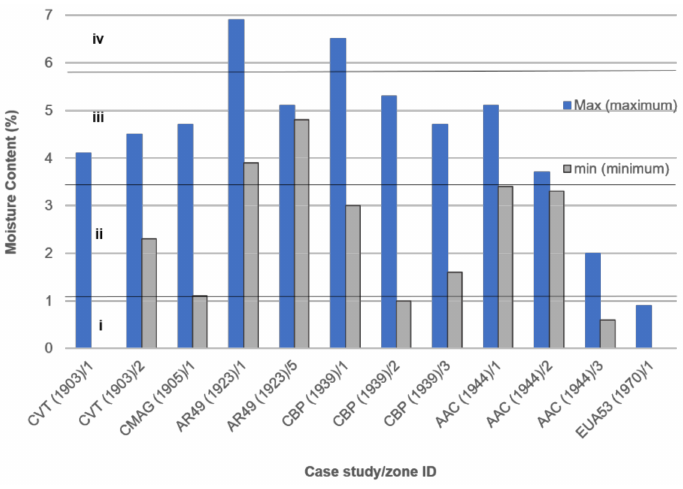
Figure 5. Moisture content (%) by tested zones. Dry zone ( i ); moderate wet zone ( ii ); wet zone ( iii ) and very wet zone ( iv